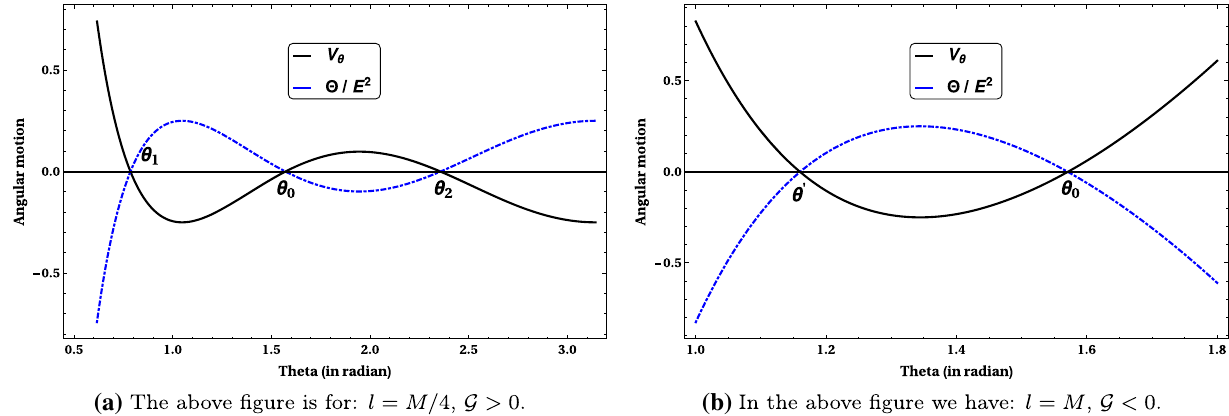
Fig. 8 The angular potential and angular momentum for the Kerr–Newman-NUT black hole has been presented with vanishing Carter constant. Among other relevant quantities the impact parameter is taken as L / E ≡ ξ = 0 . 5 M and finally the rotation parameter being a =